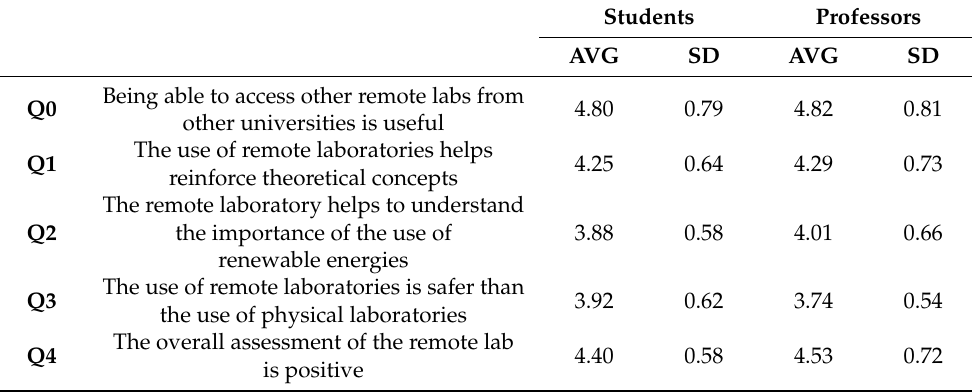
Table 7. Usefulness of remote laboratories according to the students and professors.